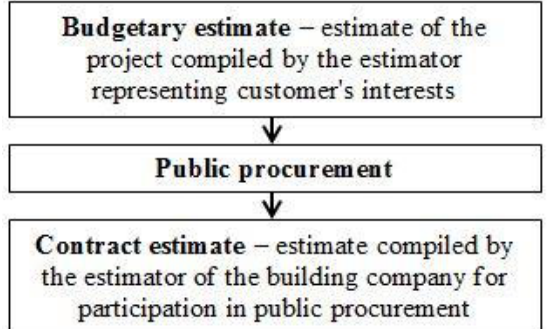
Fig. 1. Determination of building costs before the launching of the construction